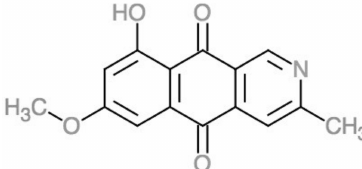
Figure 6. Structure of 5-deoxybostrycoidin. Made on ChemDoodle [77], based on Frandsen et al. [28].